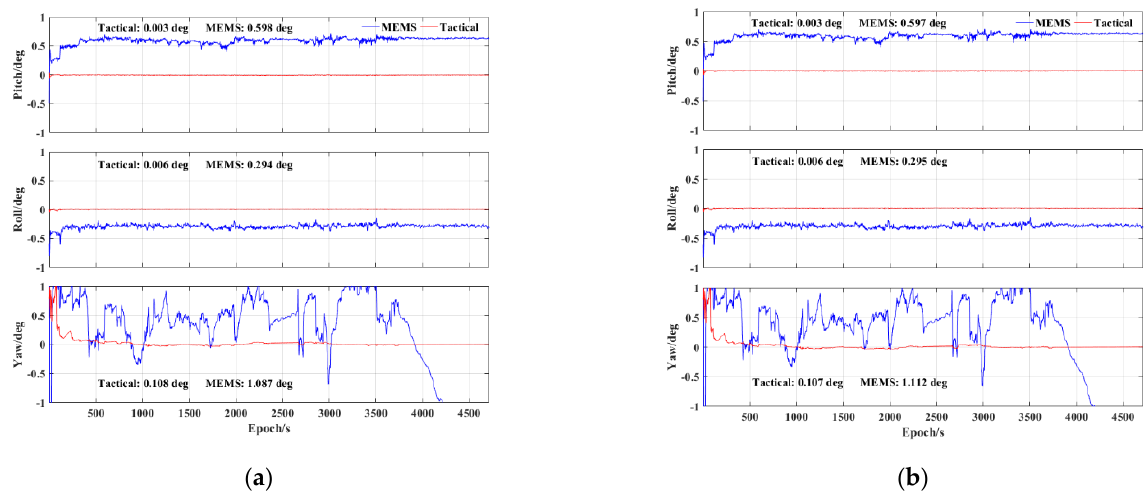
Figure 12. PPP/INS tight integration attitude error of tactical IMU and MEMS IMU: ( a ) BDS − 3 PPP − B2b RT corrections; ( b ) GFZ post − precise products.